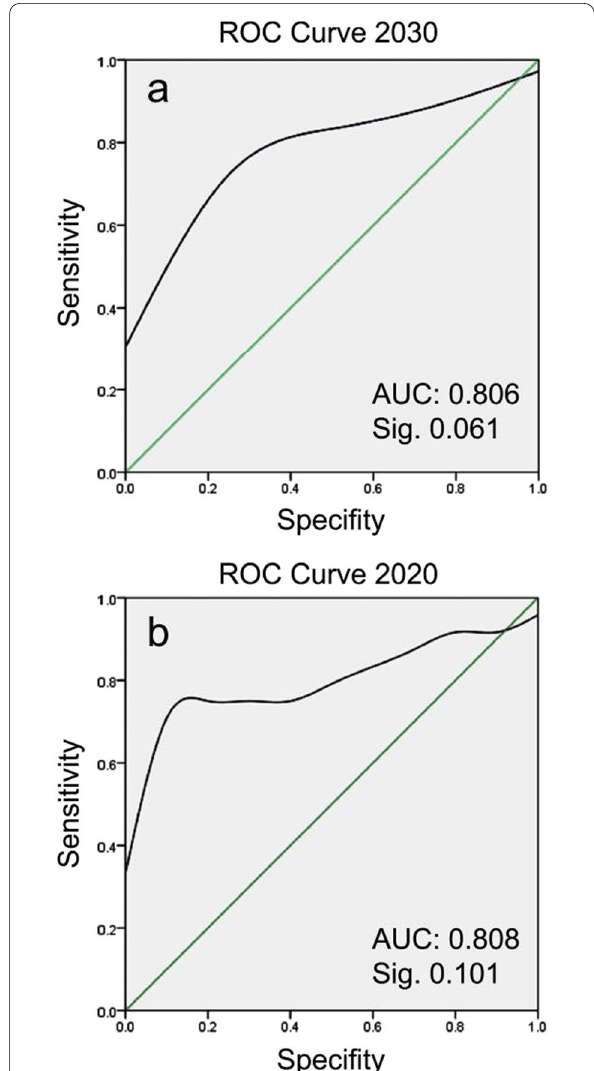
Fig. 11 ROC curve of the model for two time windows of a